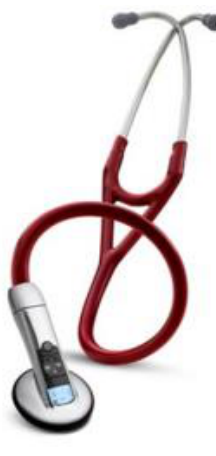
Figure 20. Littmann 3200 Bluetooth electronic stethoscope (3M)